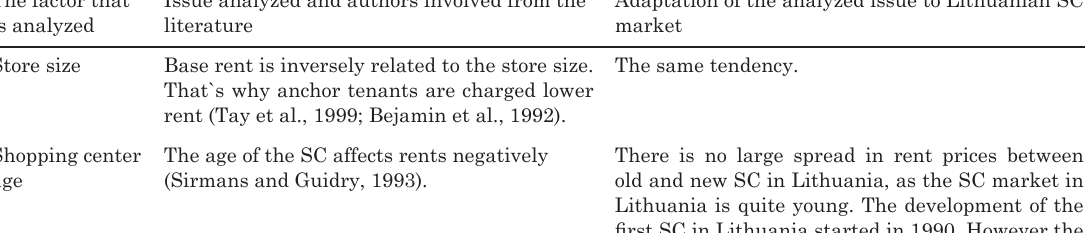
Table 1. The comparison of the factors which affect rent determination The factor that Issue analyzed and authors involved from the is analyzed literature Store size Base rent is inversely related to the store size. That`s why anchor tenants are charged lower rent (Tay et al., 1999; Bejamin et al.,